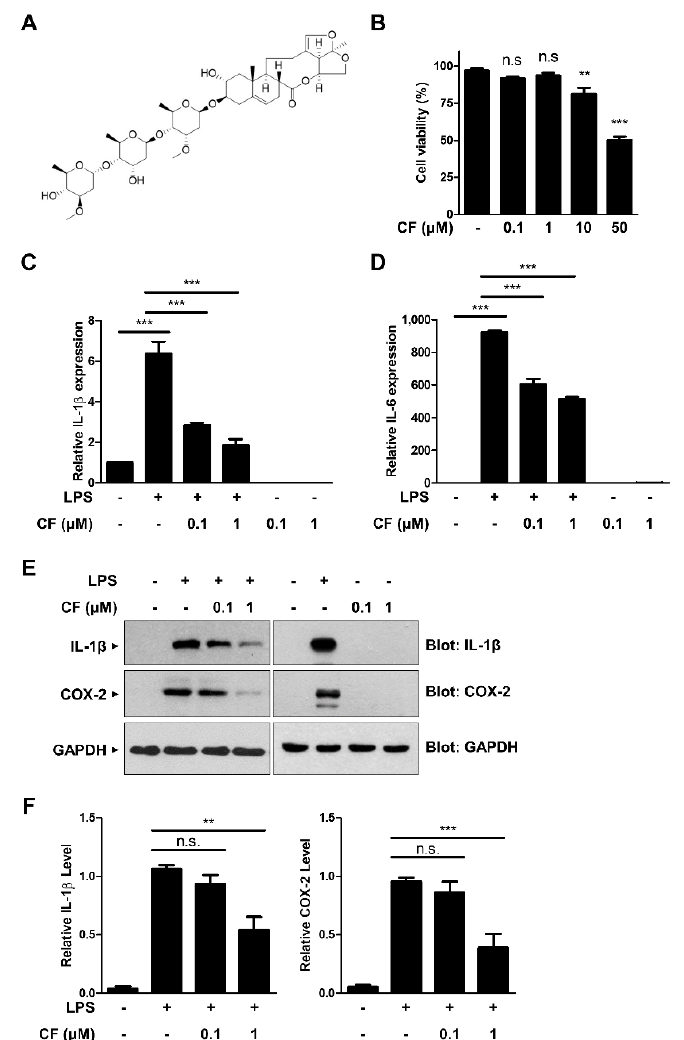
Figure 1. Inhibitory effect of CF on LPS-induced inflammatory signaling. ( A ) The chemical structure of CF. ( B ) RAW264.7 macrophages were treated with the indicated concentrations of CF for 24 h, and the MTT assay was used to determine cell viability. ( C – F ) RAW264.7 macrophage cells were pretreated with CF (0.1 and 1 µM) for 30 min before treatment with LPS (500 ng/mL) for 6 h. The mRNA expression levels of IL-1 β , IL-6, and β -actin were measured by qRT-PCR with the indicated primer sets (Table 1) and then quantified ( C , D ). Cell lysates were immunoblotted with anti-IL-1 β and anti-COX-2 antibodies. GAPDH was used as an internal control ( E , F ). The graphs are presented as the mean ± SD of three independent experiments. ** p < 0.01; *** p < 0.001; n.s., nonsignificant. Table 1. Sequences of qRT-PCR Primers.